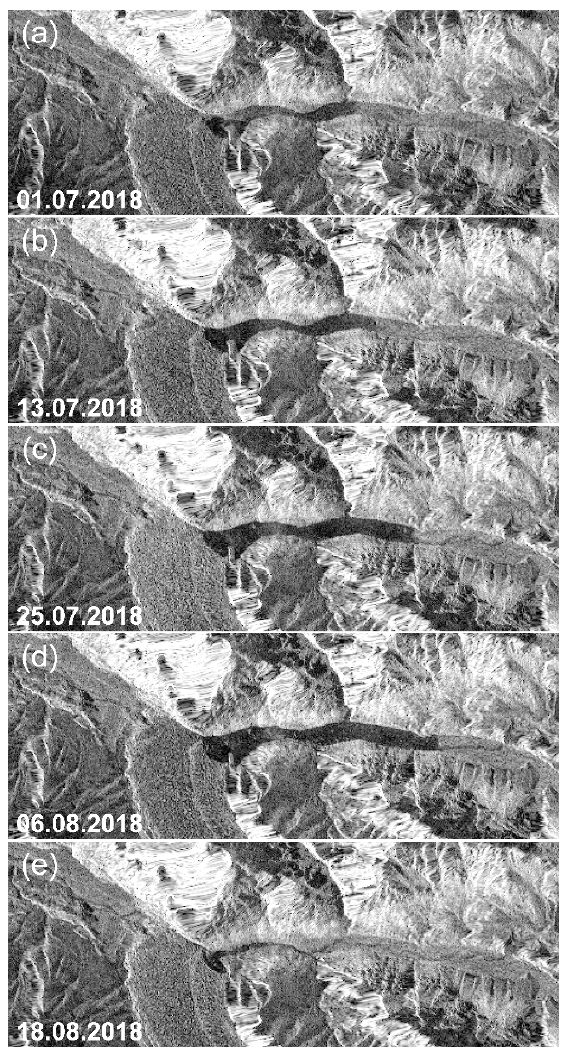
Figure 7. Radar backscattering images of the glacier terminus showing the lake dynamics before drainage ( a − d ) and ( e ) after the drainage.